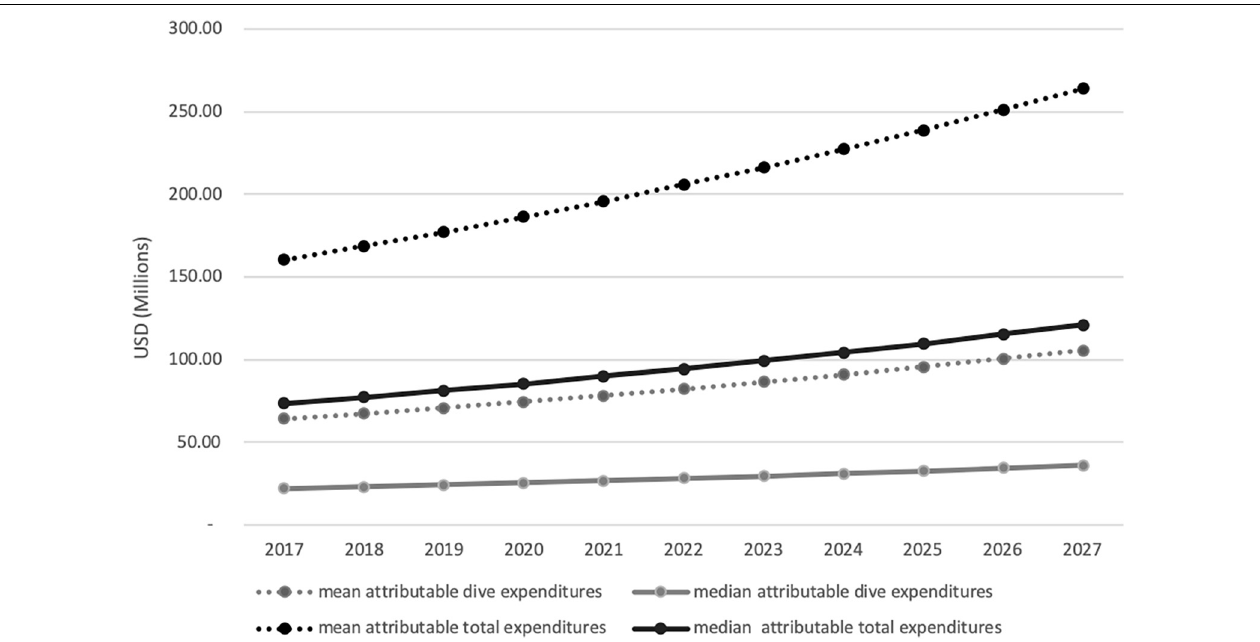
FIGURE 2 | The potential revenues 2017–2027 derived from dive and total expenditures attributable to sharks (median in solid lines, mean in dotted lines; dive in gray, total in black).